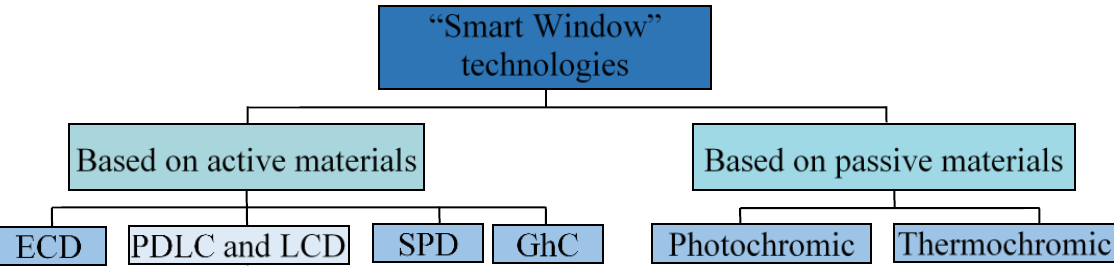
Figure 1. “Smart Windows” clas sification.